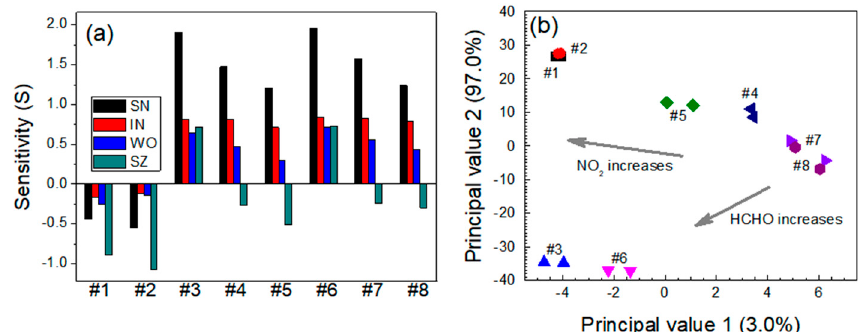
Figure 10. ( a ) Responses of the sensors and ( b ) PCA-based dual-gas sensor monitoring for the NO 2 -HCHO system. Note that #1–#8 represent 0.3 ppm NO 2 + 0 ppm HCHO, 0.6 ppm NO 2 + 0 ppm HCHO, 0 ppm NO 2 + 2.5 ppm HCHO, 0.3 ppm NO 2 + 2.5 ppm HCHO, 0.6 ppm NO 2 + 2.5 ppm HCHO, 0 ppm NO 2 + 5 ppm HCHO, 0.3 ppm NO 2 + 5 ppm HCHO, and 0.6 ppm NO 2 + 5 ppm HCHO, respectively.